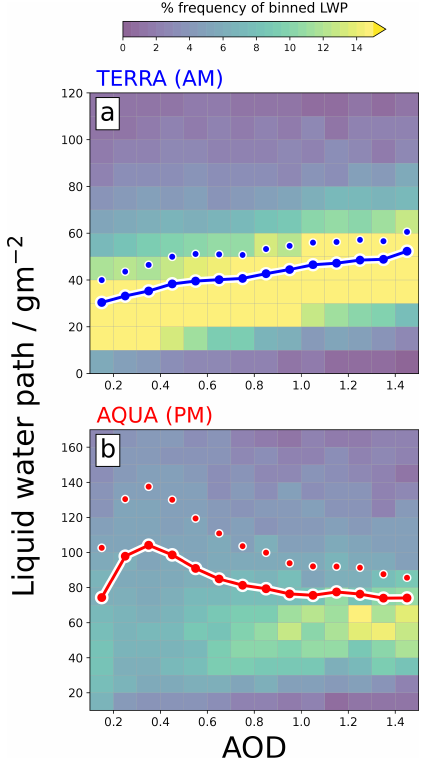
Figure 2. MODIS liquid water path as a function of AOD for the (a) morning TERRA overpass and (b) afternoon AQUA overpass. Joint histograms show % frequency of LWP binned by AOD, and coloured lines (individual circles) show the geometric (arithmetic) mean in each AOD bin. Data are only shown for cloudy scenes where LWP >